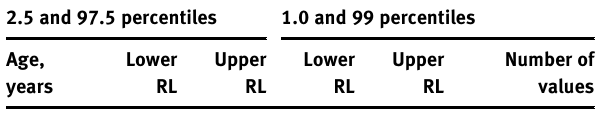
Table  : Reference limits (RLs) of hs-cardiac troponin T (ng/L) from patients of a university hospital estimated by the TMC